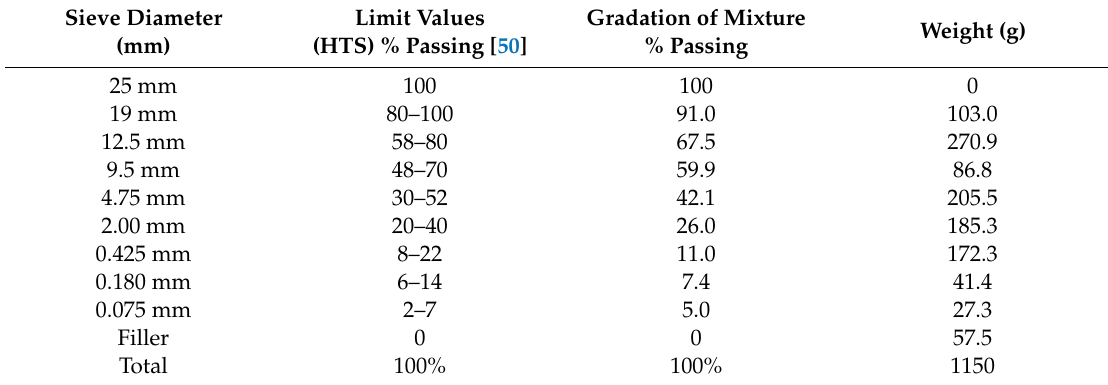
Table 1. Gradation and specification limits.